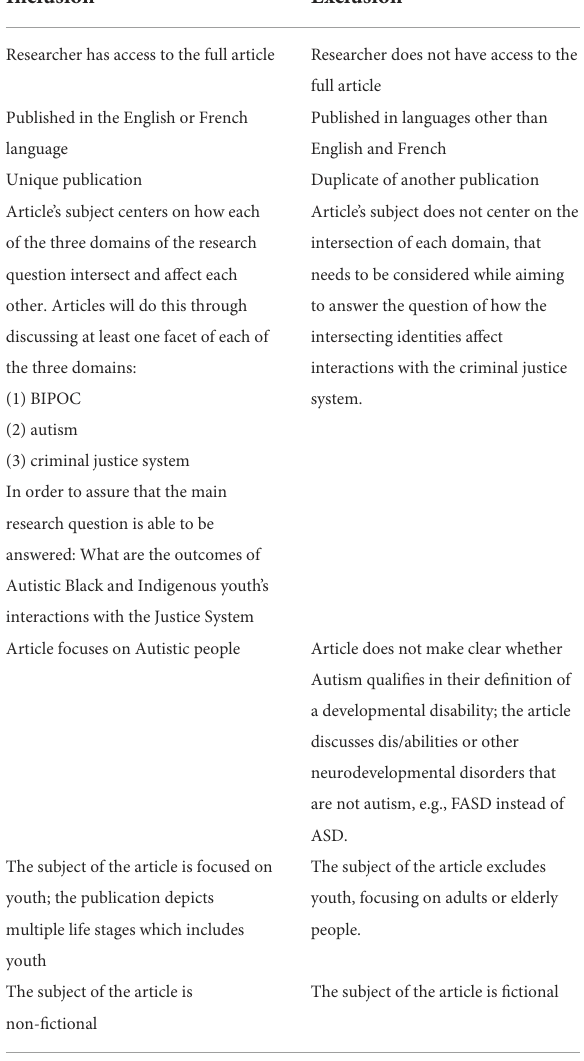
TABLE 4 Inclusion and exclusion criteria for scholarly literature review on racialized autistic individuals and the